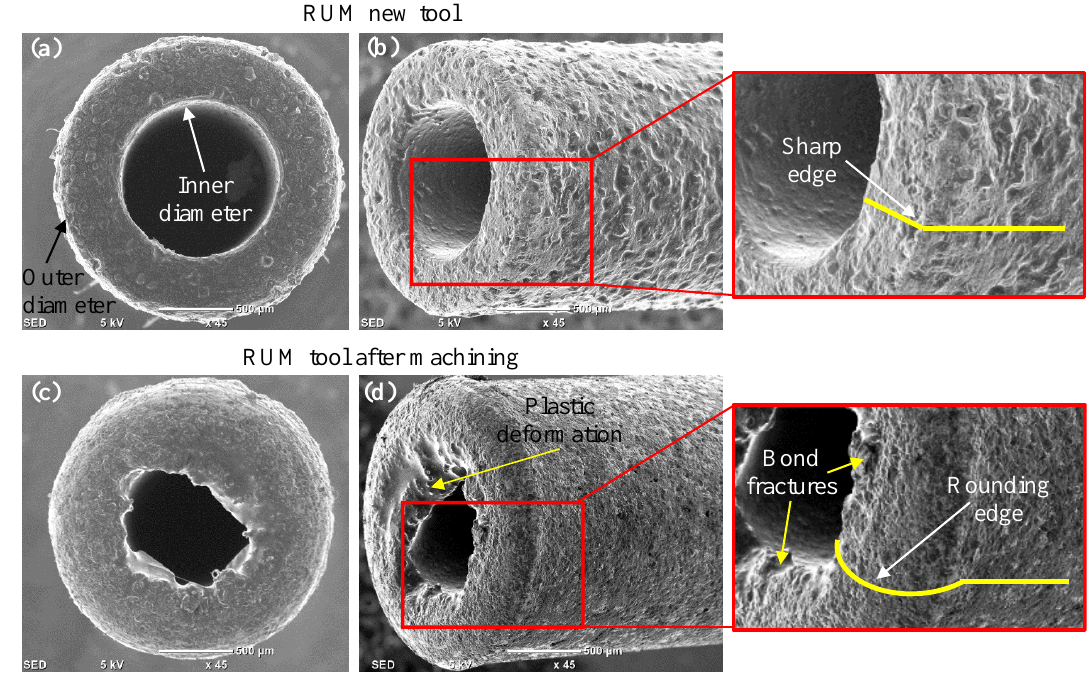
Figure 15. Comparison of the RUM new tool and the tool after machining. ( a , b ) End cutting face and a 3D view of the new RUM tool and ( c , d ) end cutting face and a 3D view of the RUM tool after machining.